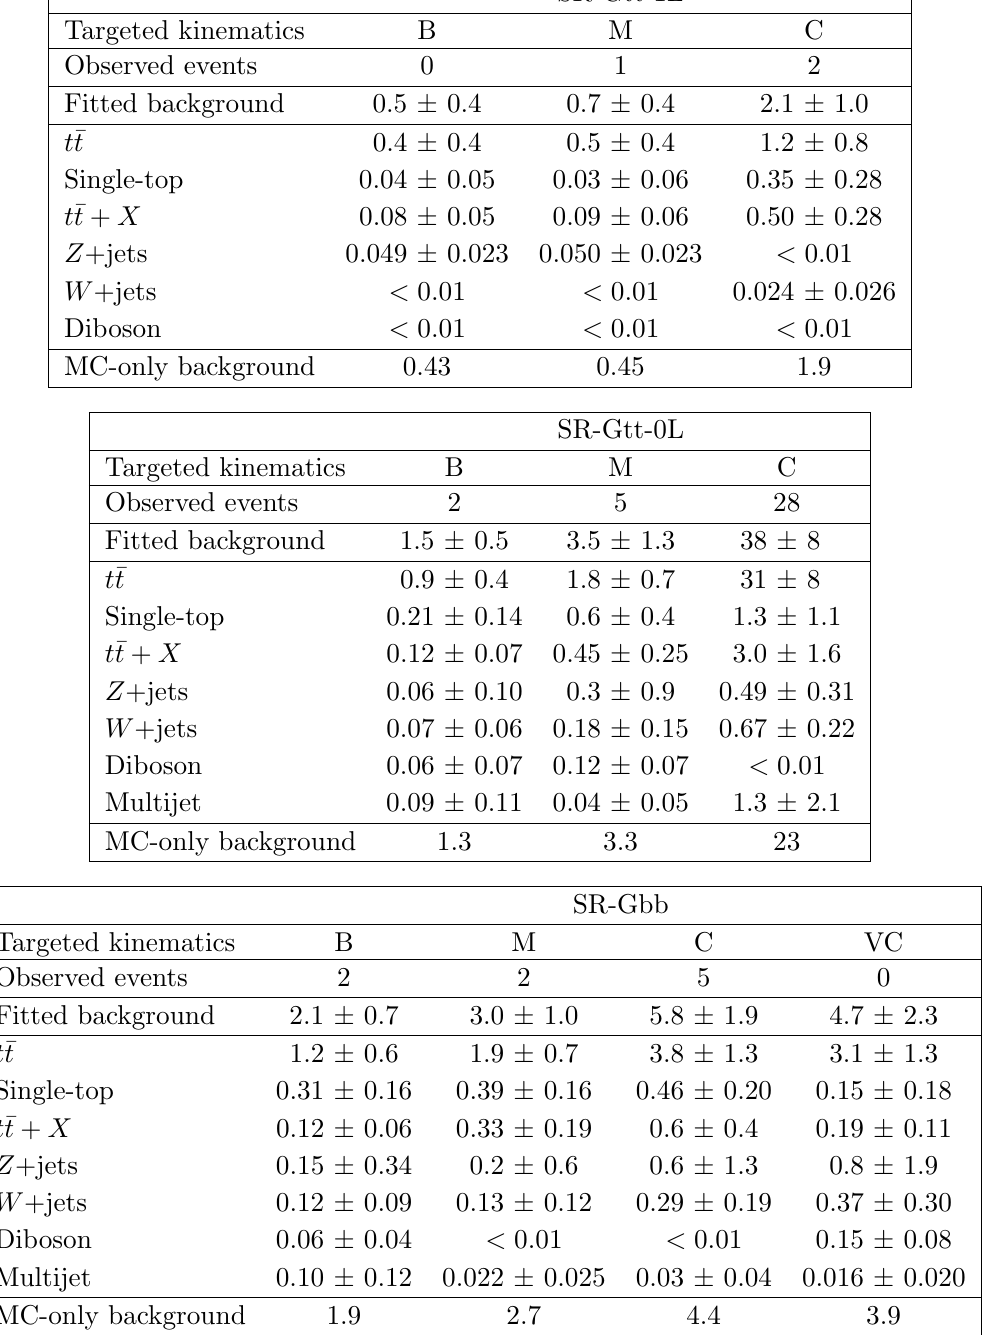
Table 7. Results of the background-only (cid:12)t extrapolated to the Gtt 1-lepton, Gtt 0-lepton and Gbb SRs in the cut-and-count analysis, for the total background prediction and breakdown of the main background sources. The uncertainties shown include all systematic uncertainties. The data in the SRs are not included in the (cid:12)t. The background category t (cid:22) t + X includes t (cid:22) tW=Z , t (cid:22) tH and t (cid:22) tt (cid:22) t events. The row \MC-only background" provides the total background prediction when the t (cid:22) t normalisation is obtained from a theoretical calculation [64].